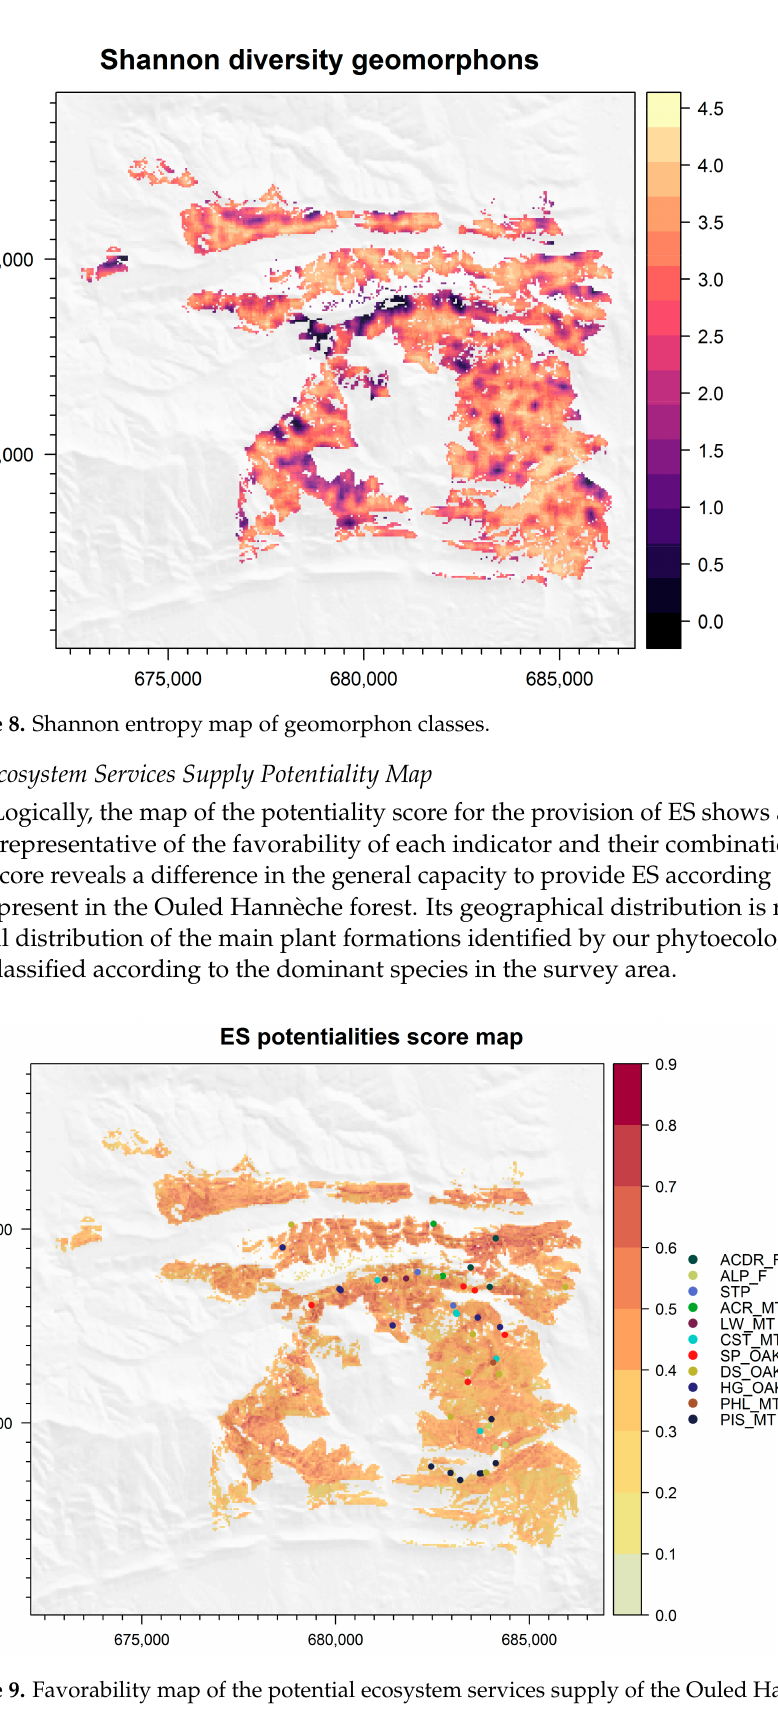
Figure 9. Favorability map of the potential ecosystem services supply of the Ouled Hann è che